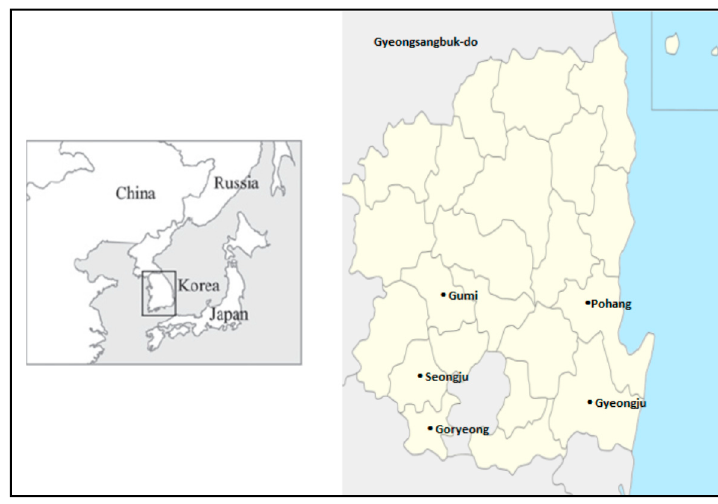
Figure 1. Location of selected study areas in Gyeongsangbuk-do Province of South Korea that were included in the case-control study.